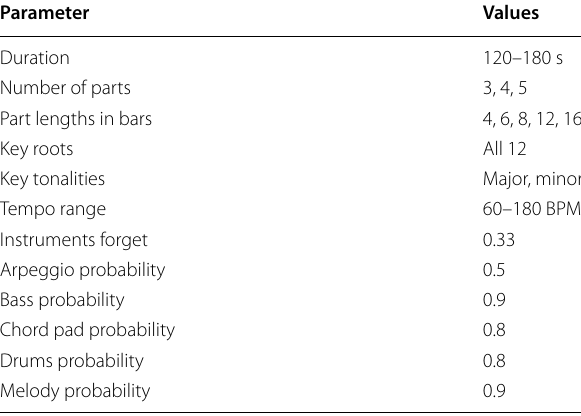
Table 3 Basic configuration parameters used to produce